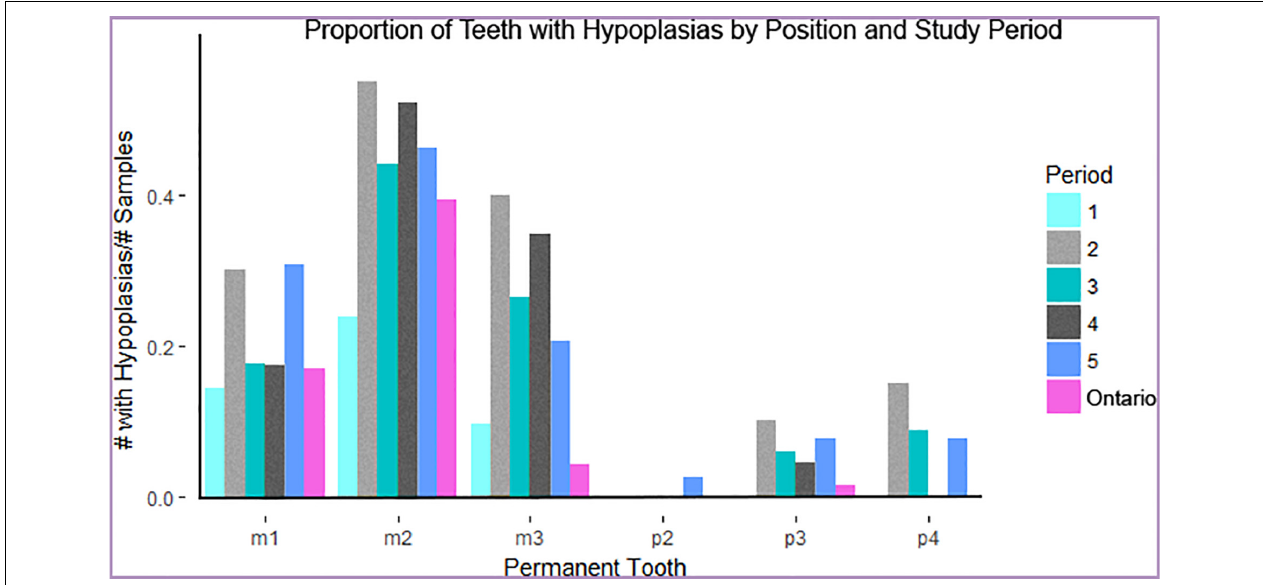
FIGURE 5 | Proportion of moose exhibiting one or more hypoplasias per tooth and time period or locality. Teeth are displayed in approximate order of development and eruption. Gray and black bars indicate high-density periods of study on Isle Royale. Ontario moose represent a mainland sample contemporaneous to period 1.